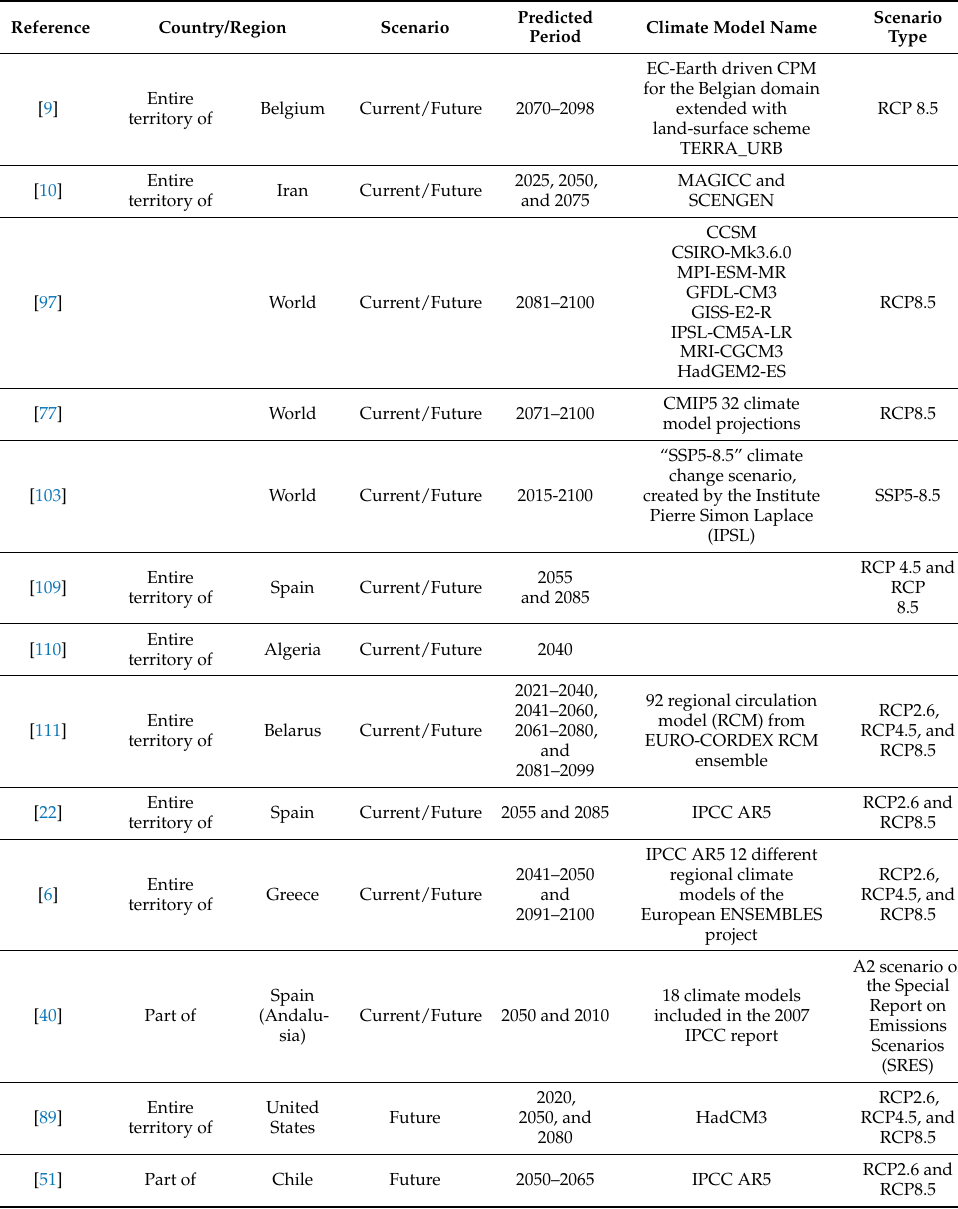
Table 6. Summary of papers for future climate